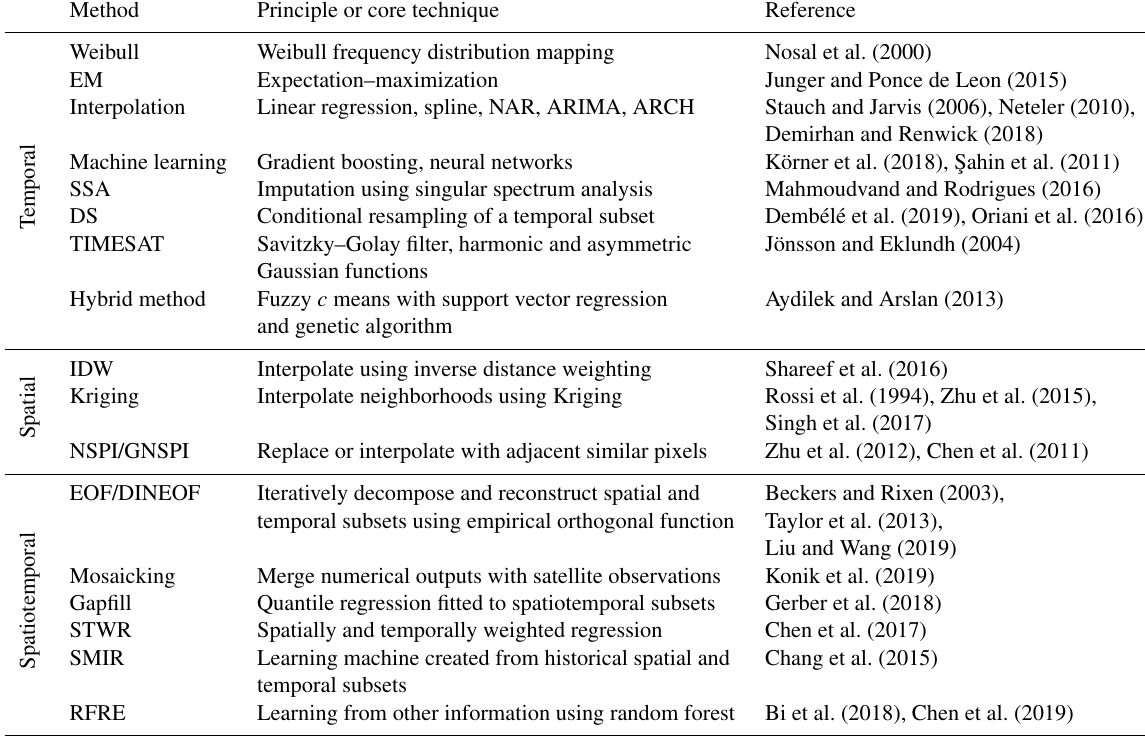
Table 1. Overview of several popular gap-filling methods to impute missingness in geophysical data